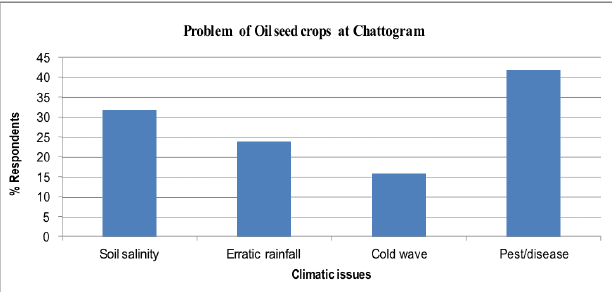
Figure 16: Farmers response on long term impacts of climate change